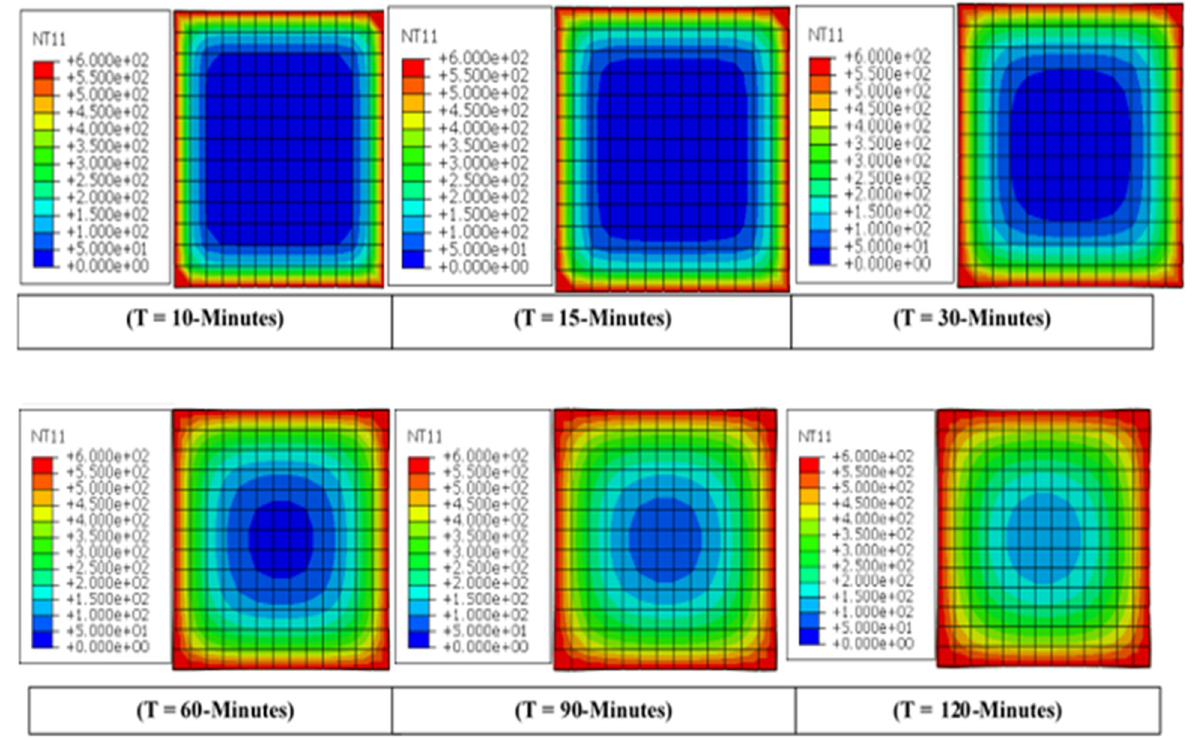
Figure 15: Heat transfer study over time for a column specimen following a 120 min burn at 600°C.